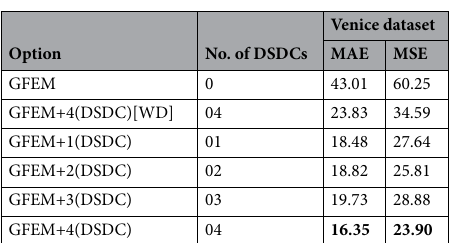
Table 3. A comparison between counting accuracy (MAE,MSE) and increasing number of DSDC’s. Whereas, (DSDC)[WD] stands for DSDC without dilation. Significance values are given in bold.